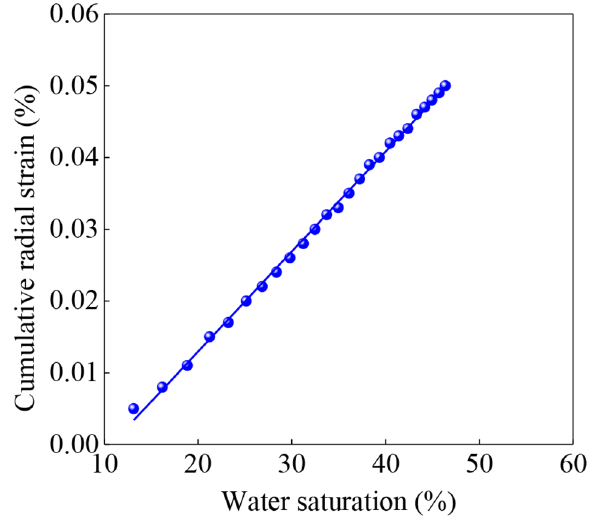
Fig. 6 Cumulative radial strain versus water saturation (1 MPa injec- tion